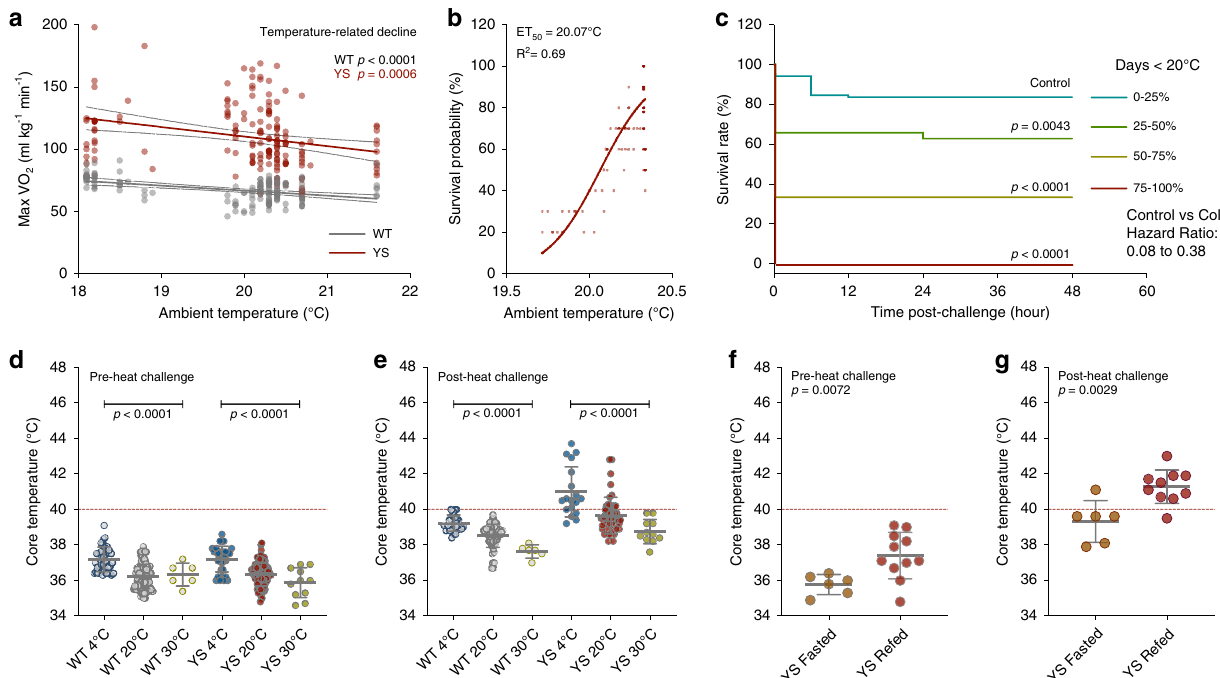
Fig. 3 Enhanced heat sensitivity and adaptive thermogenesis in Y524S mice. a Relationship of ambient housing temperature and the maxVO 2 during acute 37 °C heat challenge in WT ( n = 129) and YS ( n = 154) mice. b Effect of prior median ambient housing temperature on estimated survival probability of YS mice ( n = 154) after acute heat challenge. c Kaplan – Meier analysis of the heat challenge survival rate of YS mice ( n = 154) grouped by duration of prior ambient housing temperature at lower than 20 °C. d , e Core body temperature before ( d ) and after ( e ) acute 37 °C heat challenge in WT and YS mice preconditioned for 1 week at 4 °C (WT n = 23, YS n = 21), room temperature (WT n = 35, YS n = 40), and 30 °C (WT n = 6, YS n = 11) ambient environment. f , g Core body temperature before ( f ) and after ( g ) acute 37 °C heat challenge in YS mice preconditioned at fasted ( n = 6) and refed state ( n = 11, post-heat challenge temperature of one refed YS mice was not measured due to full body contracture). All mice were within the controlled age range (8.9 ± 0.9 week old) at the time of study. P values are indicated as analyzed by F -test for deviation from zero-slope of linear regression ( a ), Mantel – Cox log-rank test ( c ), ordinary one-way analysis of variance (ANOVA) with Dunnett ’ s multiple comparisons test ( d , e ) and Welch ’ s t test ( f , g ). All statistical tests are two-sided. R 2 values are indicated to quantify goodness-of- fi t to nonlinear regression with variable slope ( b ). Survival probability of each mouse is estimated based on the survival rate from ten mice in the respective ambient temperature ( b ) subgroups. Effect of ambient housing temperature on heat challenge survival is measured by half-maximal effective ambient housing temperature (ET 50 ) on the estimated survival probability ( b ). Data are represented as asymmetrical 95% con fi dence intervals (CI) from linear best- fi t line ( a ), or mean ± standard deviation ( d – g ). Source data are provided as a source data fi